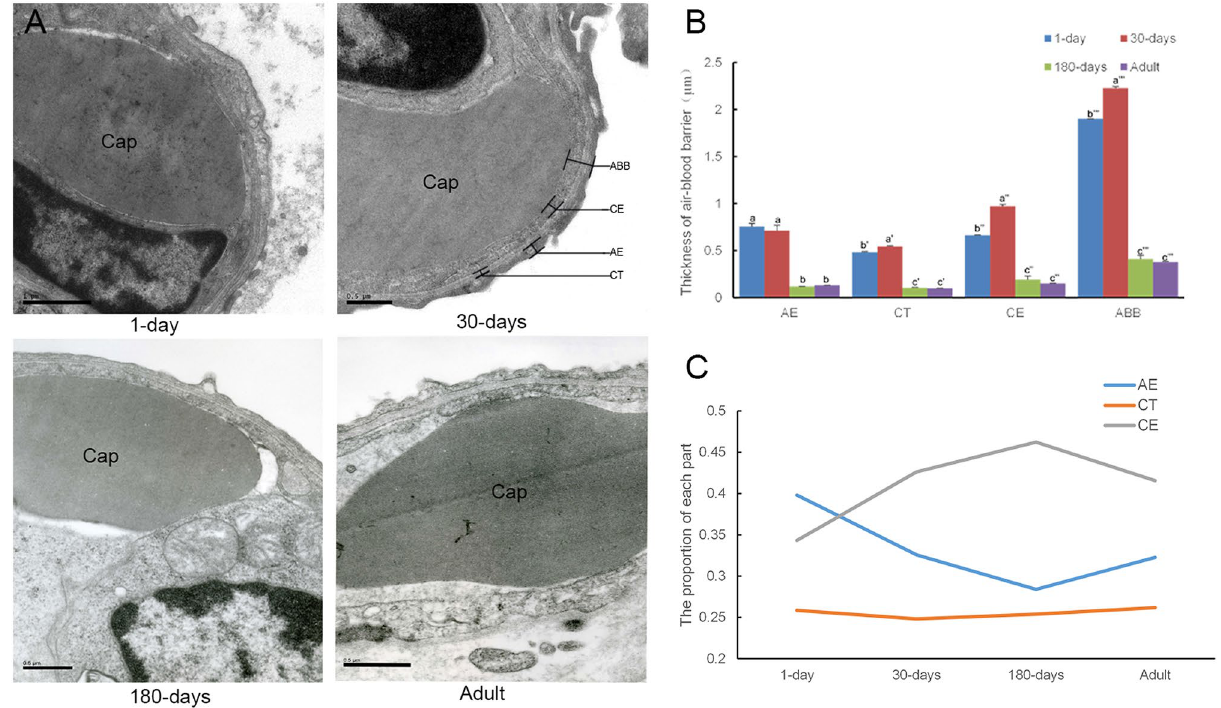
Figure 3. Images of the blood–air barrier at different developmental stages under TEM (scale bar represents 0.5 µm, 10,000×). ( A ) Cross-sectional view of the blood–air barrier in 1-day old, 30-day old, 180-day old, and adult animals under TEM. ( B ) The graph represents measurement analysis of the ABB. ( C ) The graph represents the proportions of AE, CT and CE. As age increased, the CE gradually increased, whilst the AE gradually decreased, and the CT showed almost no change. TEM, transmission electron microscopy; Cap, capillary; AE, alveolar epithelium; CT, connective tissue; CE, capillary endothelium; ABB, blood–air